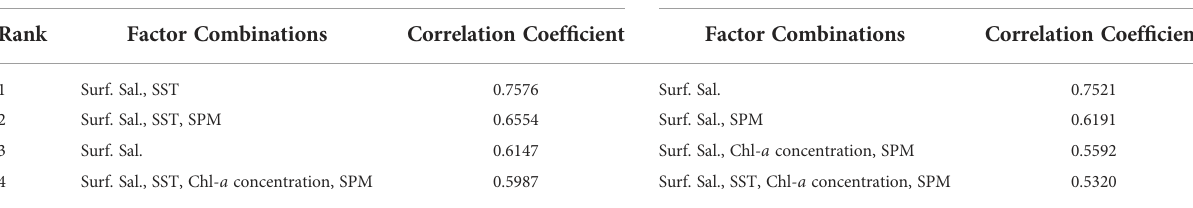
Before rainfall (June 2018)